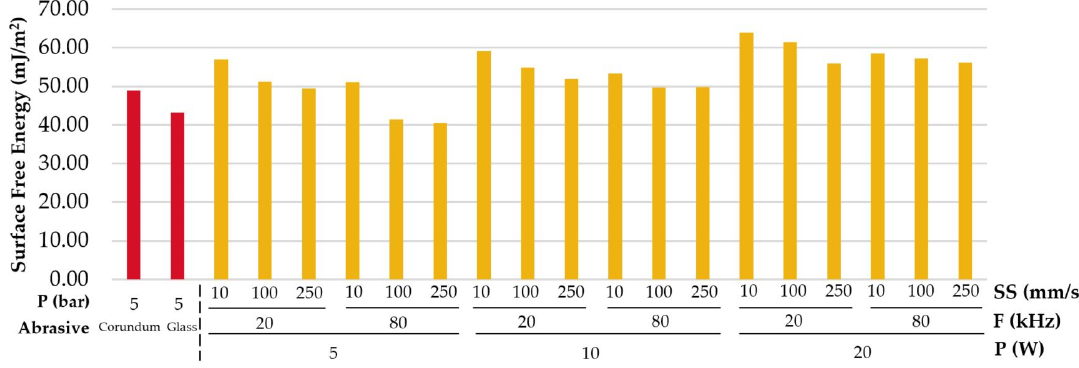
Figure 13. Surface free energy values for laser texturing tests.